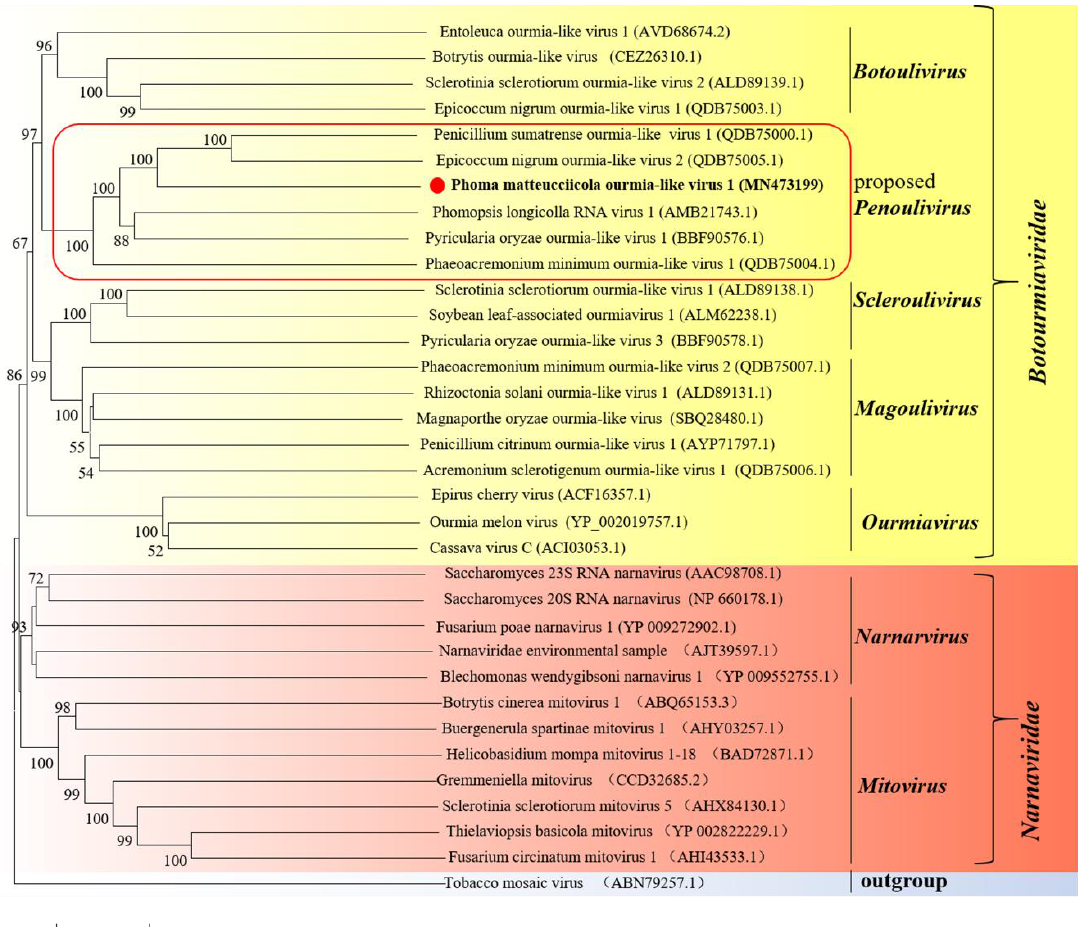
Figure 3. Phylogenetic analysis of PmOLV1 and other related viruses based on the deduced amino acid sequences of putative RdRps using the maximum-likelihood (ML) method with 1000 bootstrap replicates. The scale bar represents a genetic distance of 0.1 amino acid substitutions per site.